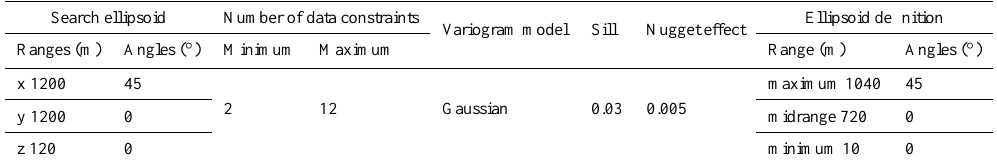
Table 5. Kriging parameters.